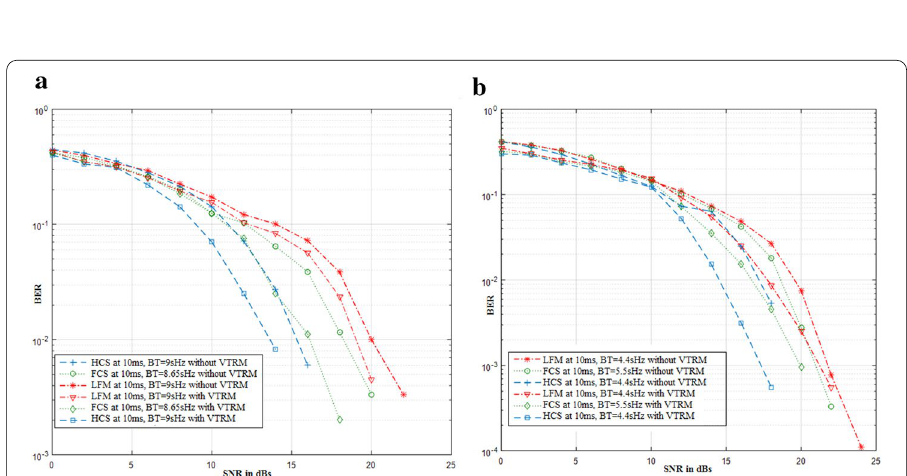
Fig. 16 BER versus SNR graph proposed system in watermark channel a BER versus SNR graph of HCS Chirp, FCS Chirp and LFM with SF 9sHz and 8.65, respectively, and Chirp Period 10 ms, b BER versus